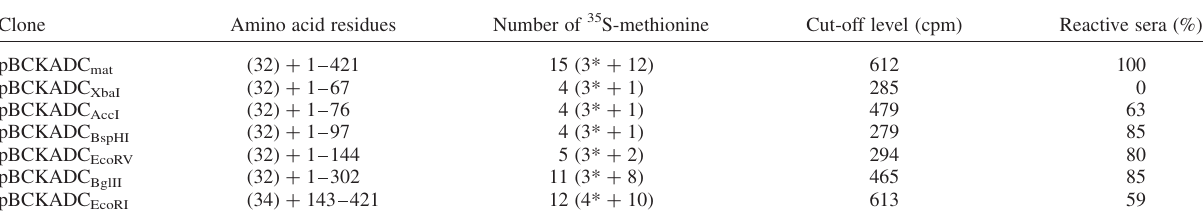
TABLE II Characteristics of recombinant proteins encoded by BCKADC-E2 cDNA clones and their reactivity with sera ( n ¼ 80) recognizing the branched-chain acyltransferase Clone Amino acid residues Number of 35 S-methionine Cut-off level